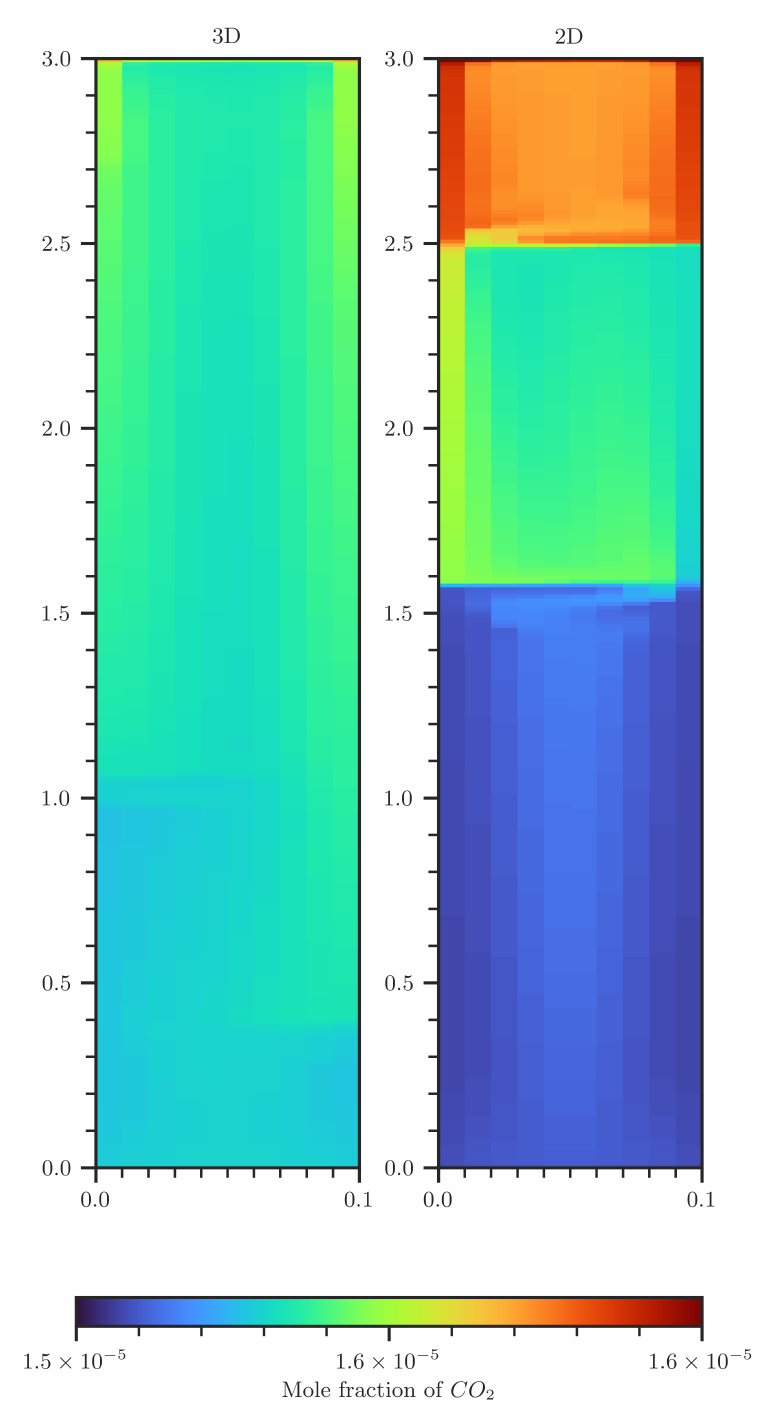
Figure A6. Comparison of CO 2 concentration contour plots of a 2D ( right ) and 3D ( left ) scenario. The 3D plot shows concentrations that are volume averaged over the second spatial